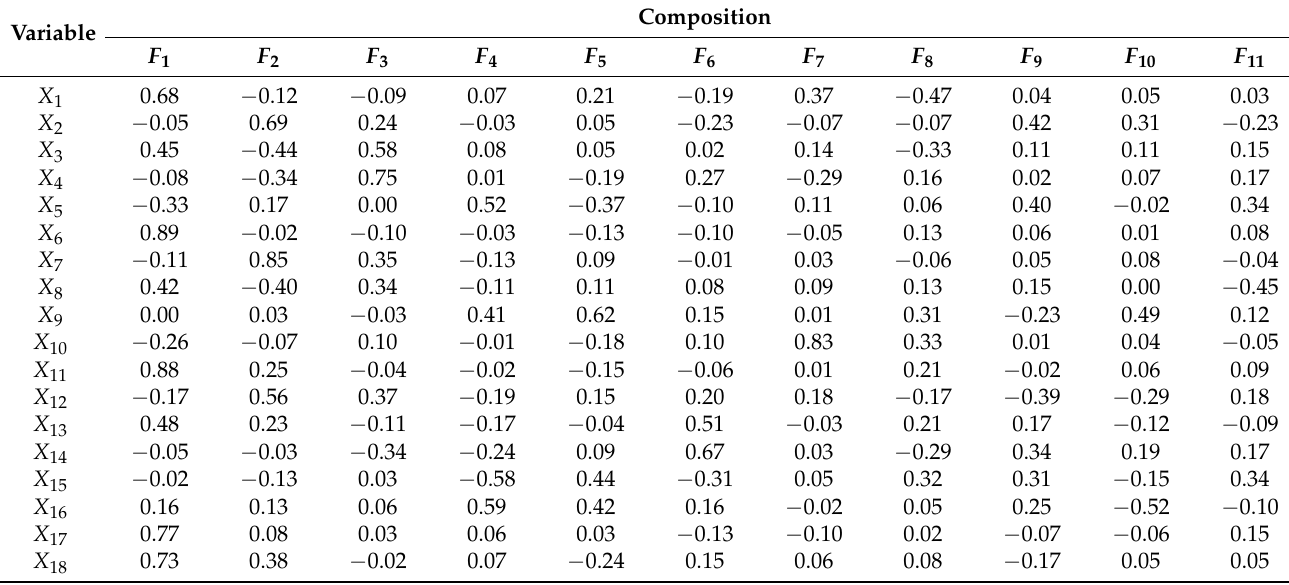
Table 4. Comprehensive score coefficient table.